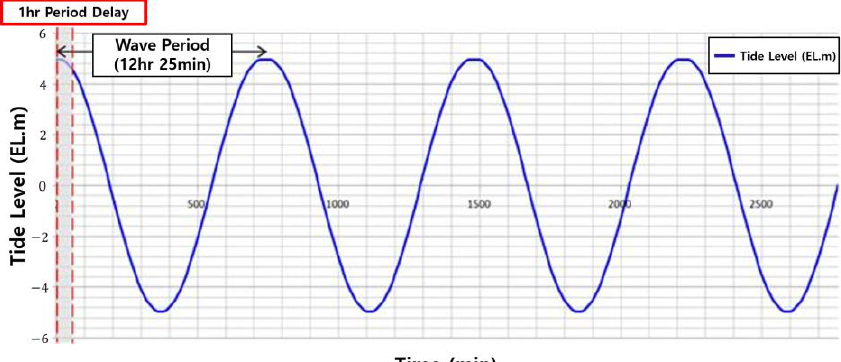
Figure 4. External Tide Water Level Curve.